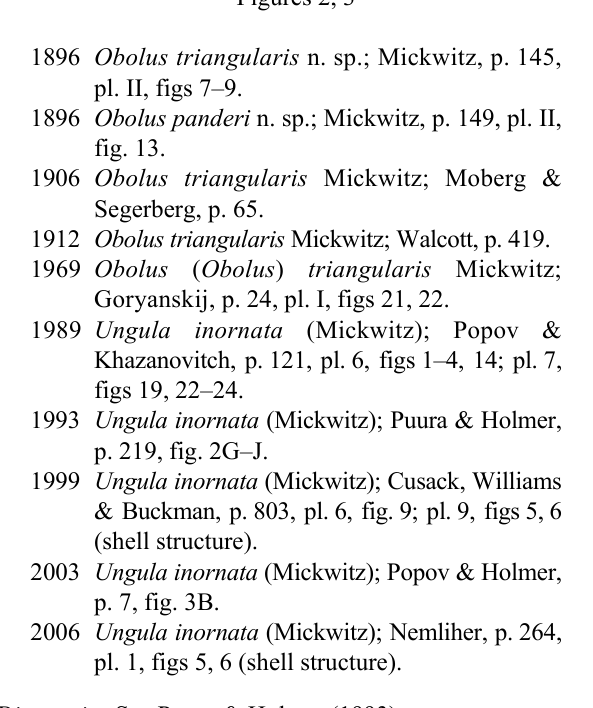
Fig. 3. Pairs of SEM photos of Ungula inornata (TUG 1323-4) from the (cid:220)lgase Formation (Cambrian, Furongian) of the (cid:220)lgase outcrop in backscattered electron (BSE; A(cid:150)H) and secondary electron (SE; A ′ (cid:150)H ′ ) imaging regimes. A / A ′ , general view of the studied valve with rectangles indicating the locations of subsequent images (B, D, E, G, H). B / B ′ , close-up of a part of A showing the alternation of compact (cl) and baculate (bl) laminae; the rectangle indicates the location of images C. C / C ′ , close-up of a part of B, showing varying preservation of baculate laminae (pointed by arrows) alternating with compact laminae. Note that the baculate structure observable in the BSE regime (C) is in part obscured in the SE image (C ′ ) by likely remains of organic matter (see arrows). D / D ′ , close-up of a part of A showing a wide baculate lamina in the upper part of the shell. The white arrow is pointing to a baculum. E / E ′ , compact and baculate laminae at the lower part of the shell showing thin fibrils, well observable both in BSE (E) and SE (E ′ ) regimes; the rectangle indicates the location of image F. F / F ′ , close-up of nanofibrils observable in E. Note the effect of BSE (F) and SE (F ′ ) regimes on the observable width of the fibrils. G / G ′ , bacula from the upper middle part of the shell covered with aggregates of apatite (spherulites), creating an impression of rather thick bacula in cross section. Note the better observable bacula in BSE images (G) and better expressed crust-like surface features observable in SE images (G ′ ). H / H ′ , alternation of baculate (bl) and compact (cl) laminae in the middle part of the shell; both laminae are composed of aggregates of apatite needles. Compact laminae occur usually in pairs, separated by a membranous lamina (ml). Note the sharper contrast in the BSE image (H) helping to locate membranous laminae within compact laminae and richer information on the sculpture of the broken surface of compact laminae in the SE image (H ′